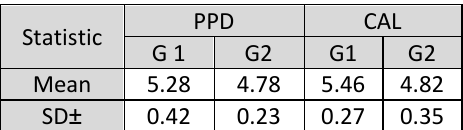
Table (3): Descriptive statistics (mean ±SD) of PPD and CAL in each group.